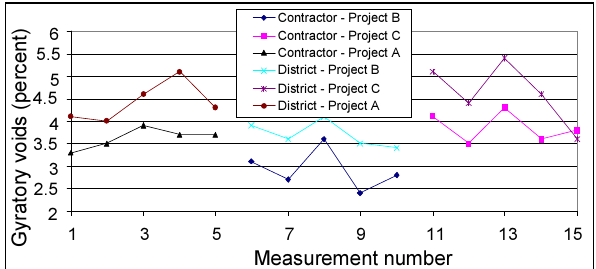
Fig. 1. Contrast in air void measurements in 3 projects